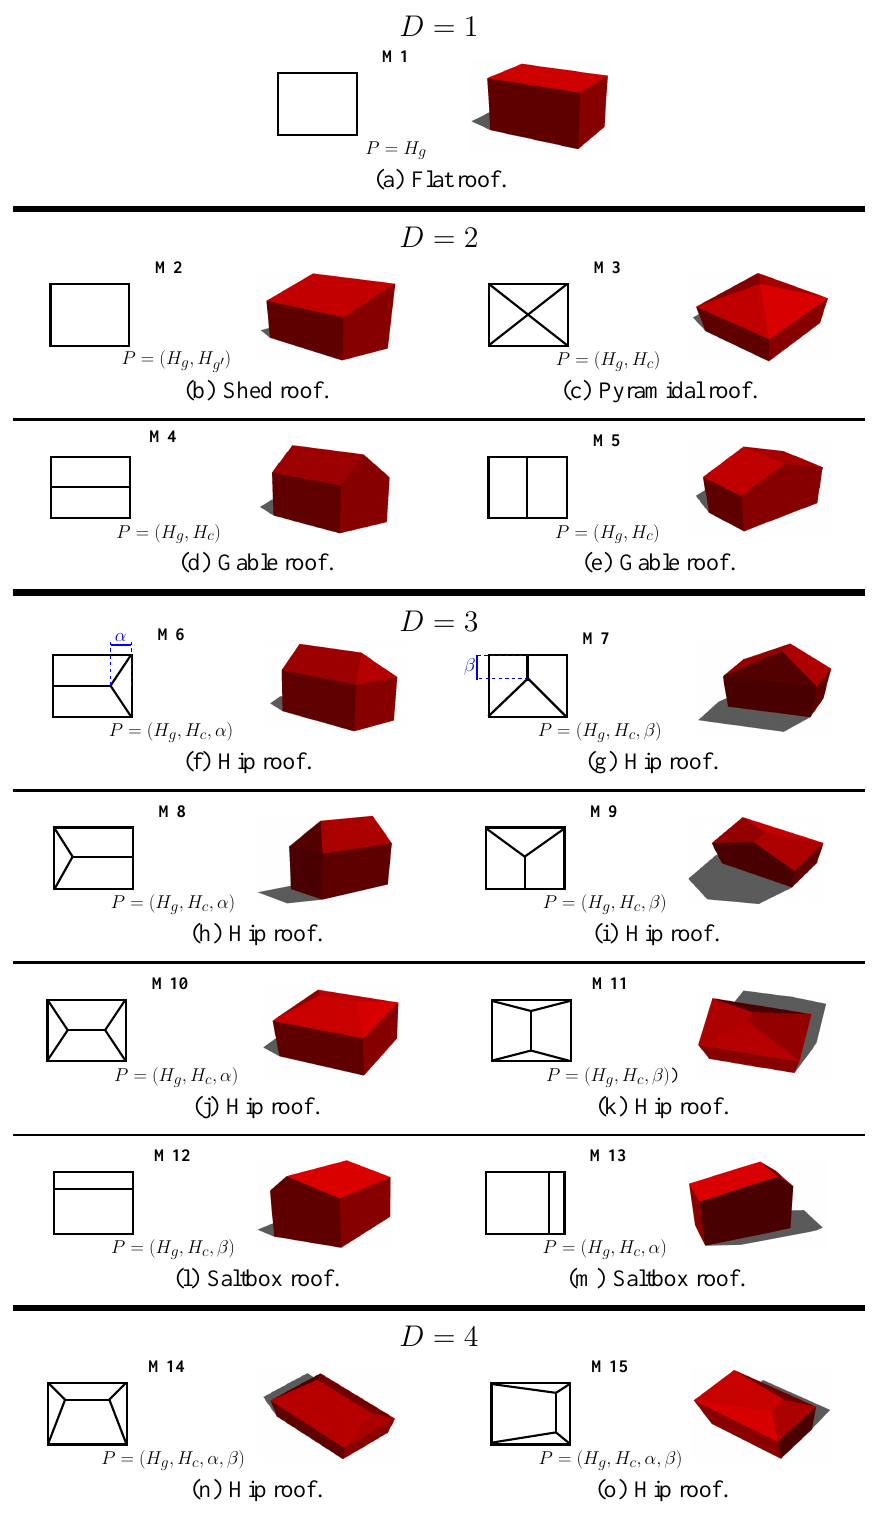
Figure 5. Samples of parametric building models M that can be reconstructed by our proposed featureless approach. Standard polyhedral shapes and their corresponding ground footprints are shown. D corresponds to the number of parameters. P denotes the model parameters. H and H correspond to the gutter height and the central line height. α and β g c respectively represent the horizontal and vertical recess as illustrated in